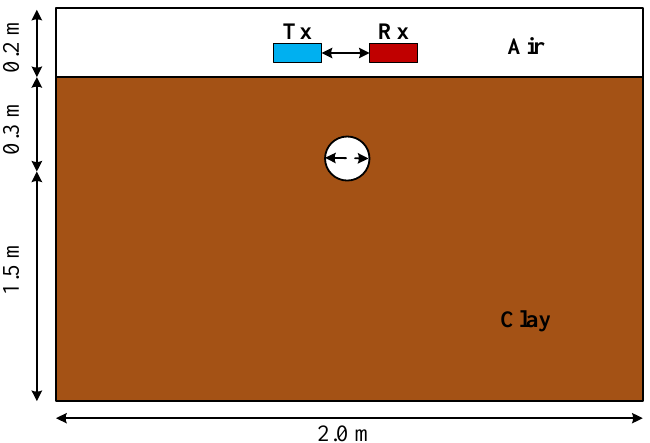
Figure 5. Schematic diagram of the circular cavity model.